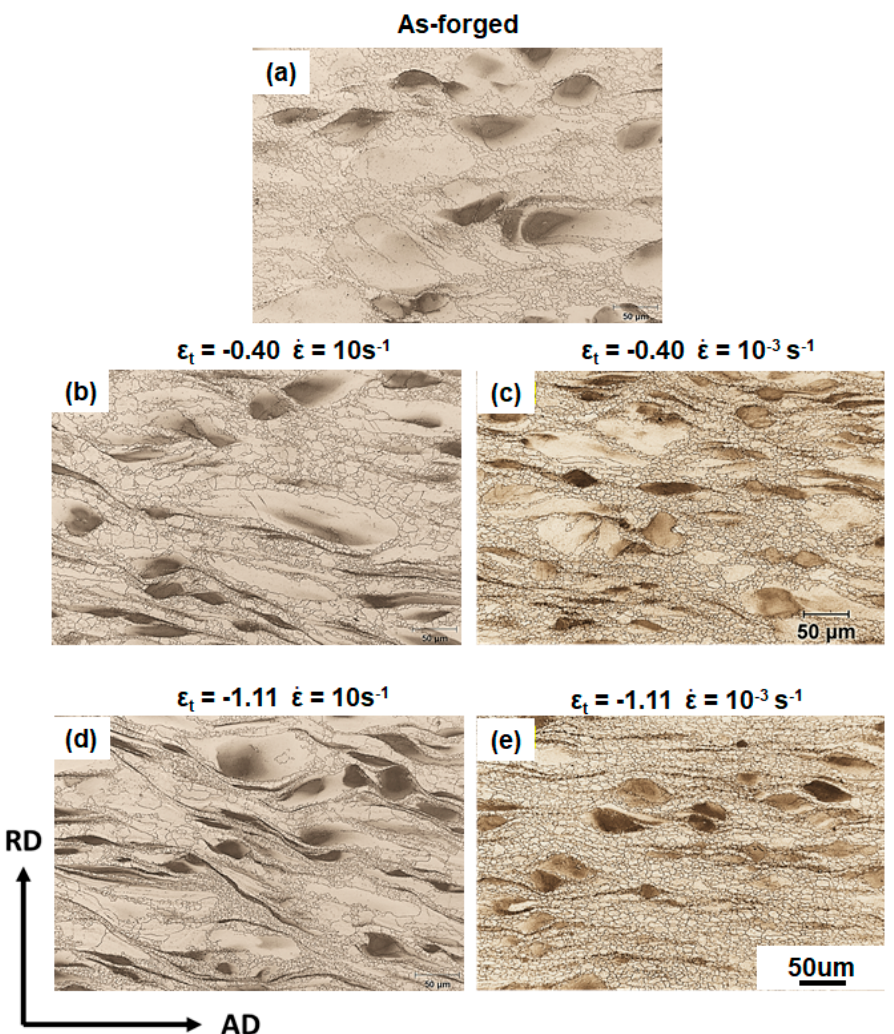
Figure 5. Optical micrographs of microstructures in different states: ( a ) as-forged state, after deformation at (cid:2013)(cid:4662) of 10 s − 1 with ε t of ( b ) − 0.40 and ( d ) − 1.11, after deformation at (cid:2013)(cid:4662) of 10 − 3 s − 1 with ε t of ( c ) − 0.40 and ( e ) − 1.11.